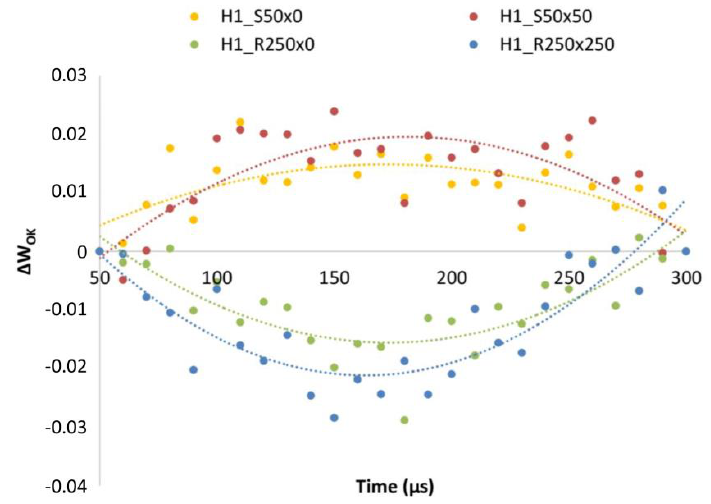
Figure 5. Fluorescence transient curves normalized between F O and F K for PGR treatment in H1 soil.